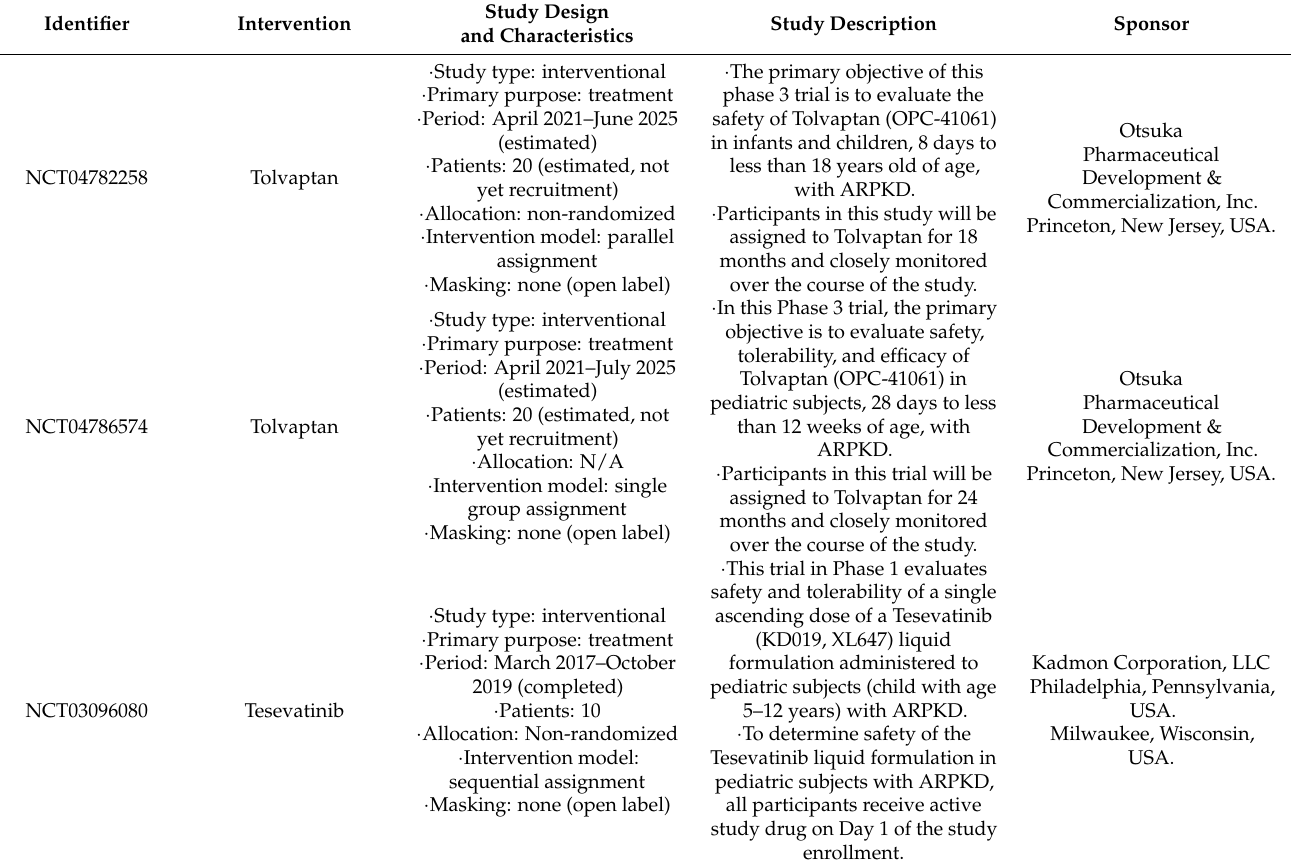
Table 2. Currently active or complete clinical trials for